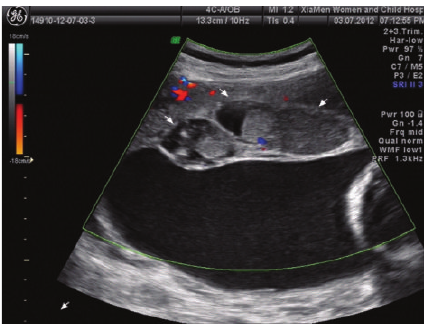
Figure 3: Ultrasonography shows a circumscribed echogenic mass measuring 115×110×112 mm containing anechoic cystic areas with pulsatile blood flow. The mass protrudes from the fetal surface of the placenta into the amniotic cavity.